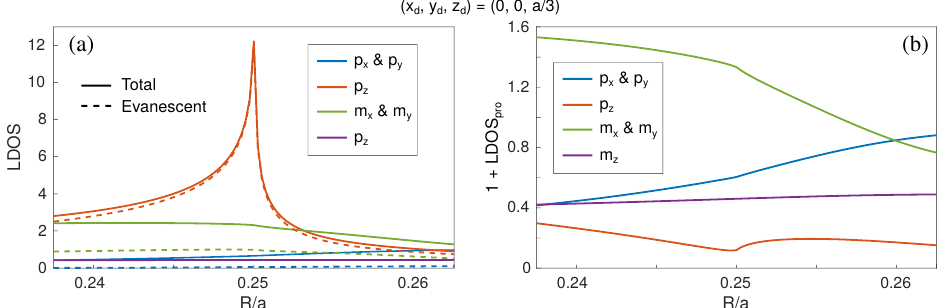
Figure 6. LDOS for the Si nanosphere metasurface shown in Figure 1a as a function of R / a for a fixed wavelength ( λ = 552 nm) at the unit cell center and at distance of z d = a /3 ≈ 133 nm. All the different electromagnetic dipolar contributions are included: in-plane electric ( p x , p y , blue) and magnetic ( m x , m y , green), and vertical electric ( p z , red) and magnetic ( m z , purple), separating: ( a ) total (solid curves) and evanescent (dashed curves) contributions; and ( b ) propagating contributions. The maximum of the evanescent p z contribution at R / a ∼ 0.25 corresponds to the wavelength of the symmetry-protected ED-BIC at the Γ point in Figure 1e for R = 100